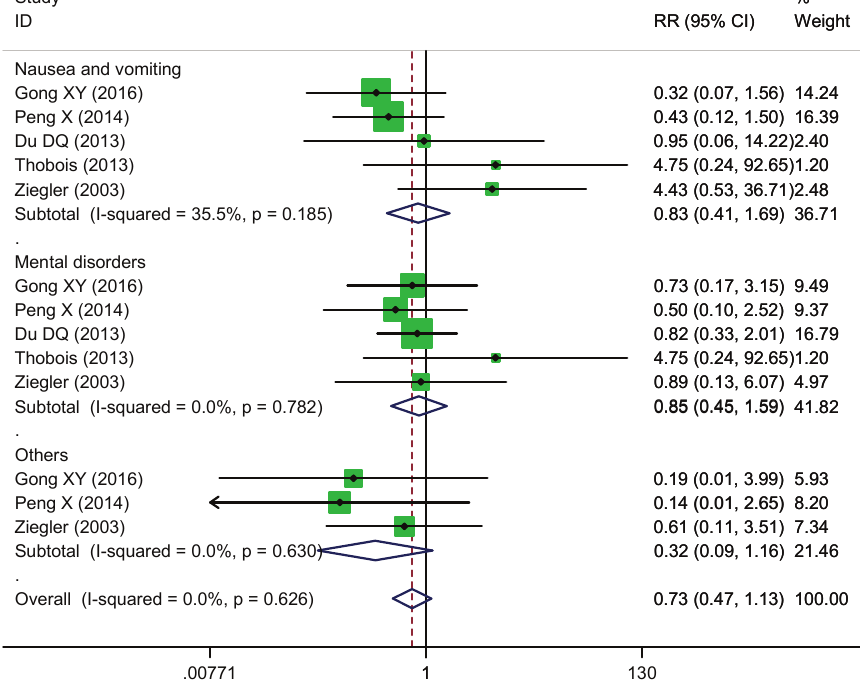
Figure 4: Forrest plot of side effects of piribedil in adjuvant treatment of Parkinson’s Disease